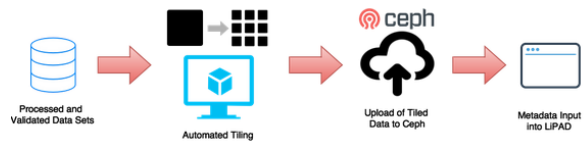
Figure 4. Semi-automated Archiving and Metadata updating